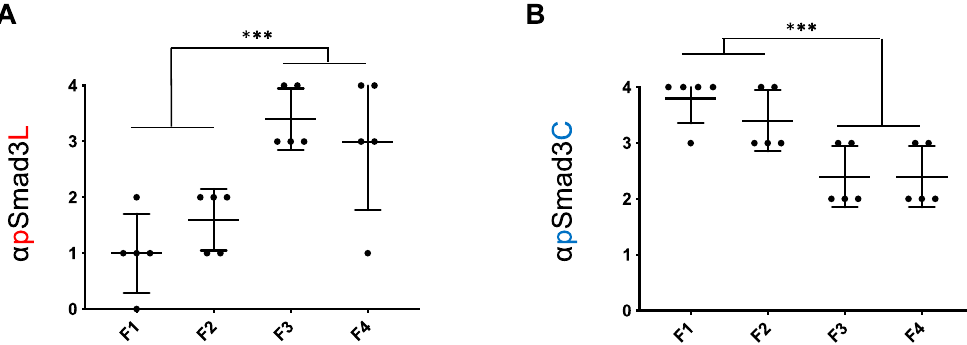
Figure 3. Hepatocytic Smad phospho-isoform signaling shifted from the pSmad3C pathway to the pSmad3L pathway as HCV-related chronic liver disorders progressed. ( A ) Extent of hepatocytic phosphorylation at Smad3L increased in relation to increasing fibrosis in HCV-related chronic liver disorders. Hepatocytic phosphorylation of Smad3L in highly fibrotic livers (fibrosis stage3 to 4) was significantly greater than in livers with stage1 to 2 fibrosis. *** p < 0.001 ( B ) Extent of phosphorylation at Smad3C decreased as fibrosis increased in HCV-related chronic liver disorders. Phosphorylation of Smad3C in hepatocytes of highly fibrotic livers (stage3 to 4) was lower than in livers with stage1 to 2 fibrosis. *** p < 0.001 Specimens from livers chronically infected with HCV were graded based on degree of fibrosis (1 to 4). Smad3 phosphorylation was scored from 0 to 4 as described in Methods. Dots ( • ) represent pSmad3L ( A ) and pSmad3C ( B ) positivity for each liver specimen. Horizontal bars indicate mean phospho-Smad3 positivity in each group. The linker region of Smad3 displayed very little phosphorylation in normal liver (data not shown).